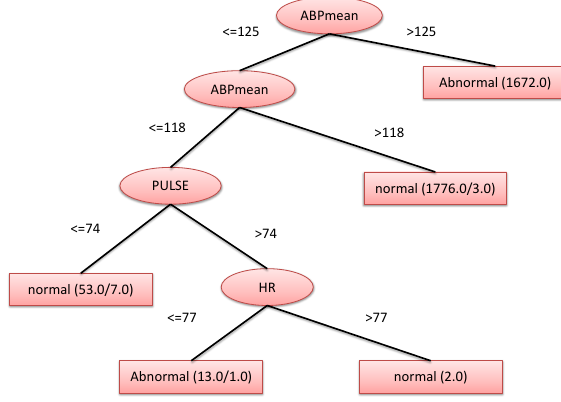
Figure 7. Resulting decision